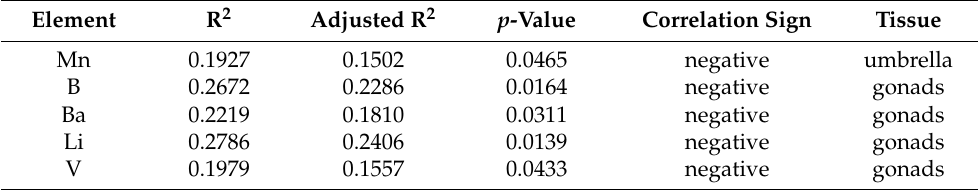
Table 5. Values of R 2 for significant correlations ( p < 0.05) for linear regressions of the element concentration vs. specimen size. Number of samples for each regression = 21.